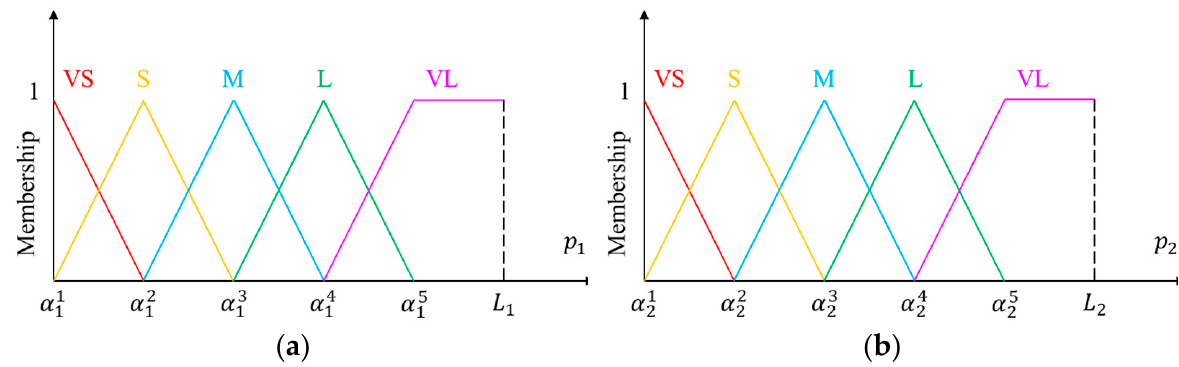
Figure 9. Fuzzy sets of antecedent variables: ( a ) input 1, and ( b ) input 2.